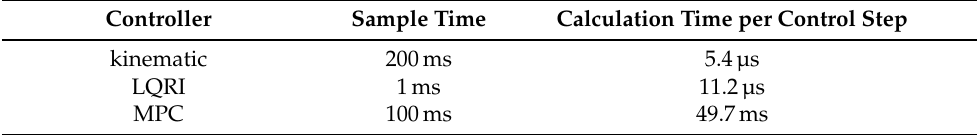
Table 5. Computation time and sample time of the three controllers for the step